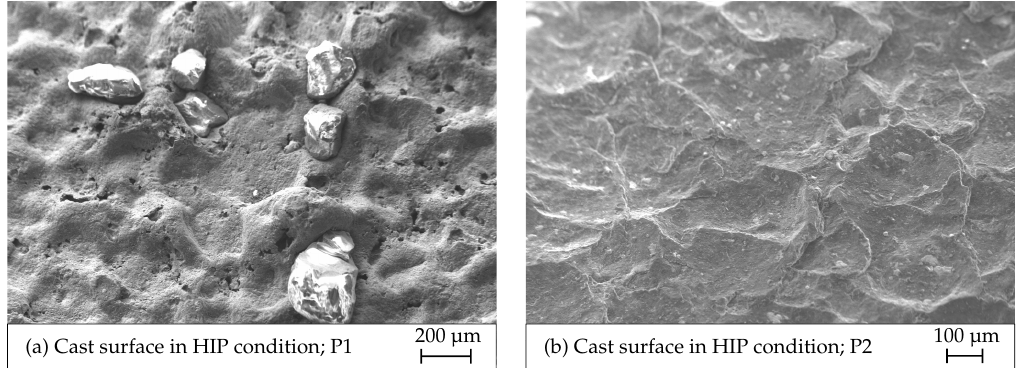
Figure 8. SEM image of the specimen series T6 P1 investigated in [36].